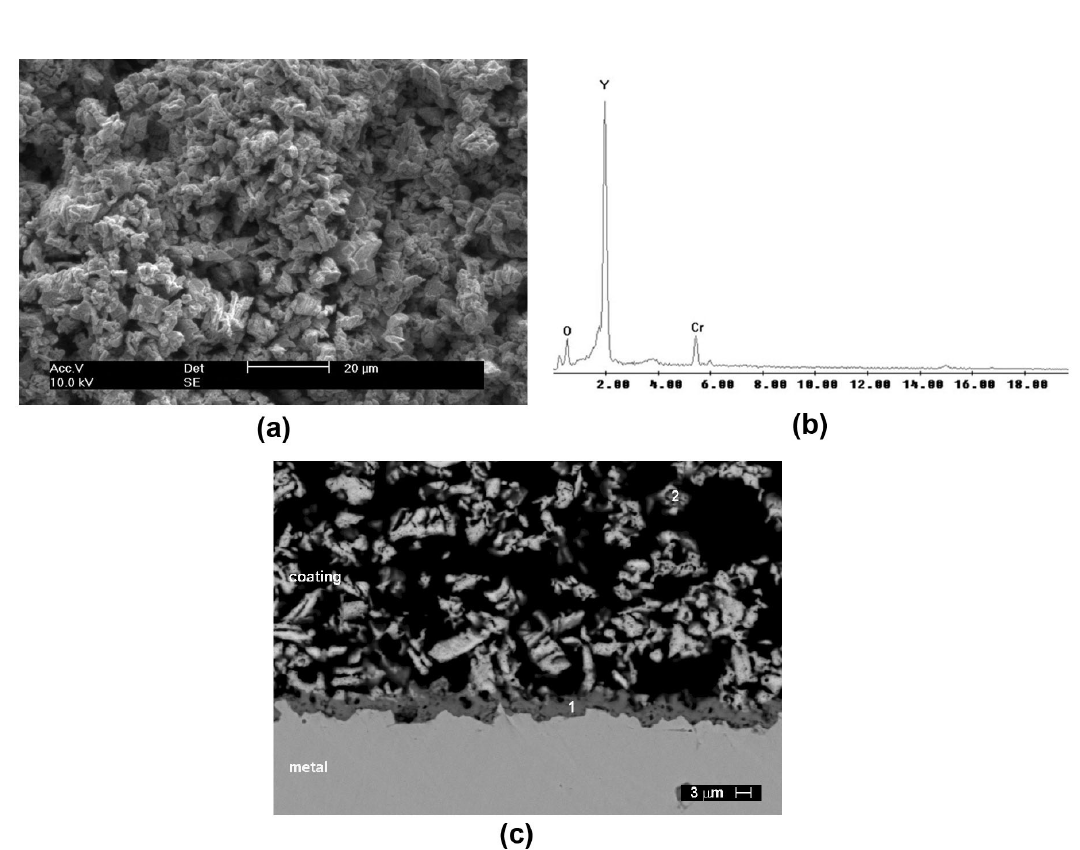
Figure 3: Scanning electron micrographs and the EDS spectrum of Y (a) The surface; (b) the EDS spectrum of the surface; (c) cross-section.